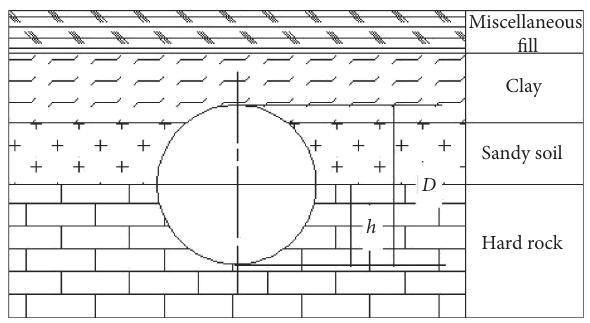
Figure 4: Composite stratum sketch map of shield tunneling in- terval at Tongdewei-Shangbu Station.